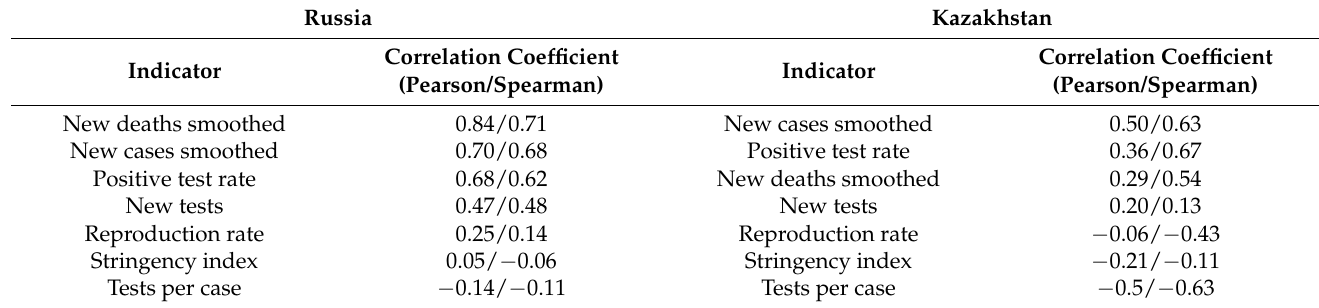
Table 7. Correlation between numbers of news stories with positive sentiment and COVID-19